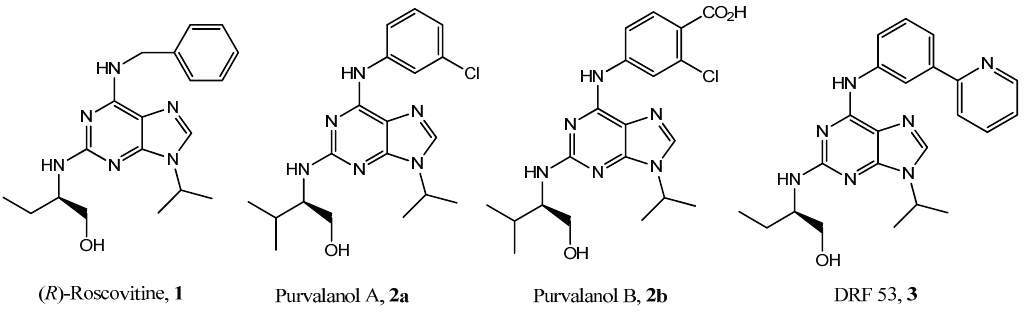
Figure 1. Chemical structures of some purine CDK